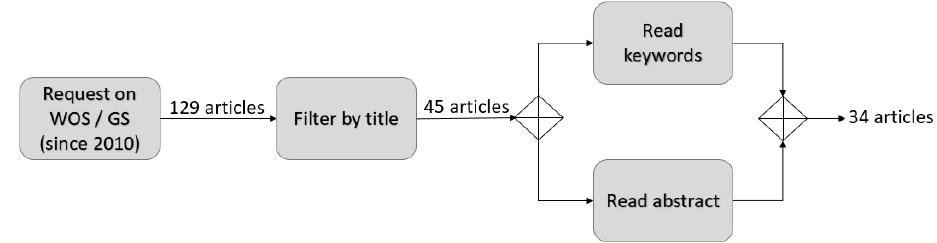
Figure 2. Steps of searching for the current literature